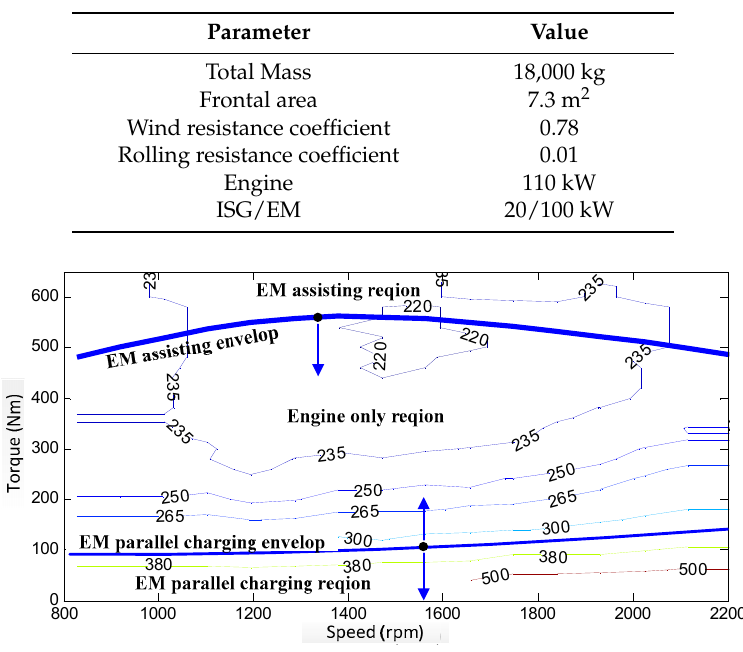
Table 1. Parameters of public transit hybrid electric bus (PTHEB). ISG: integrated starter/generator; and EM: electric motor.